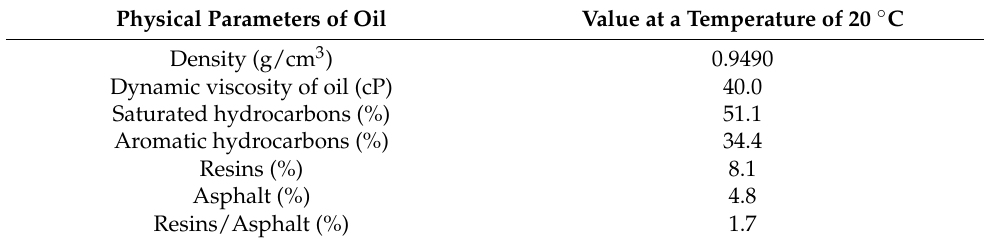
Table 1. Properties and composition of the oil of the studied field.